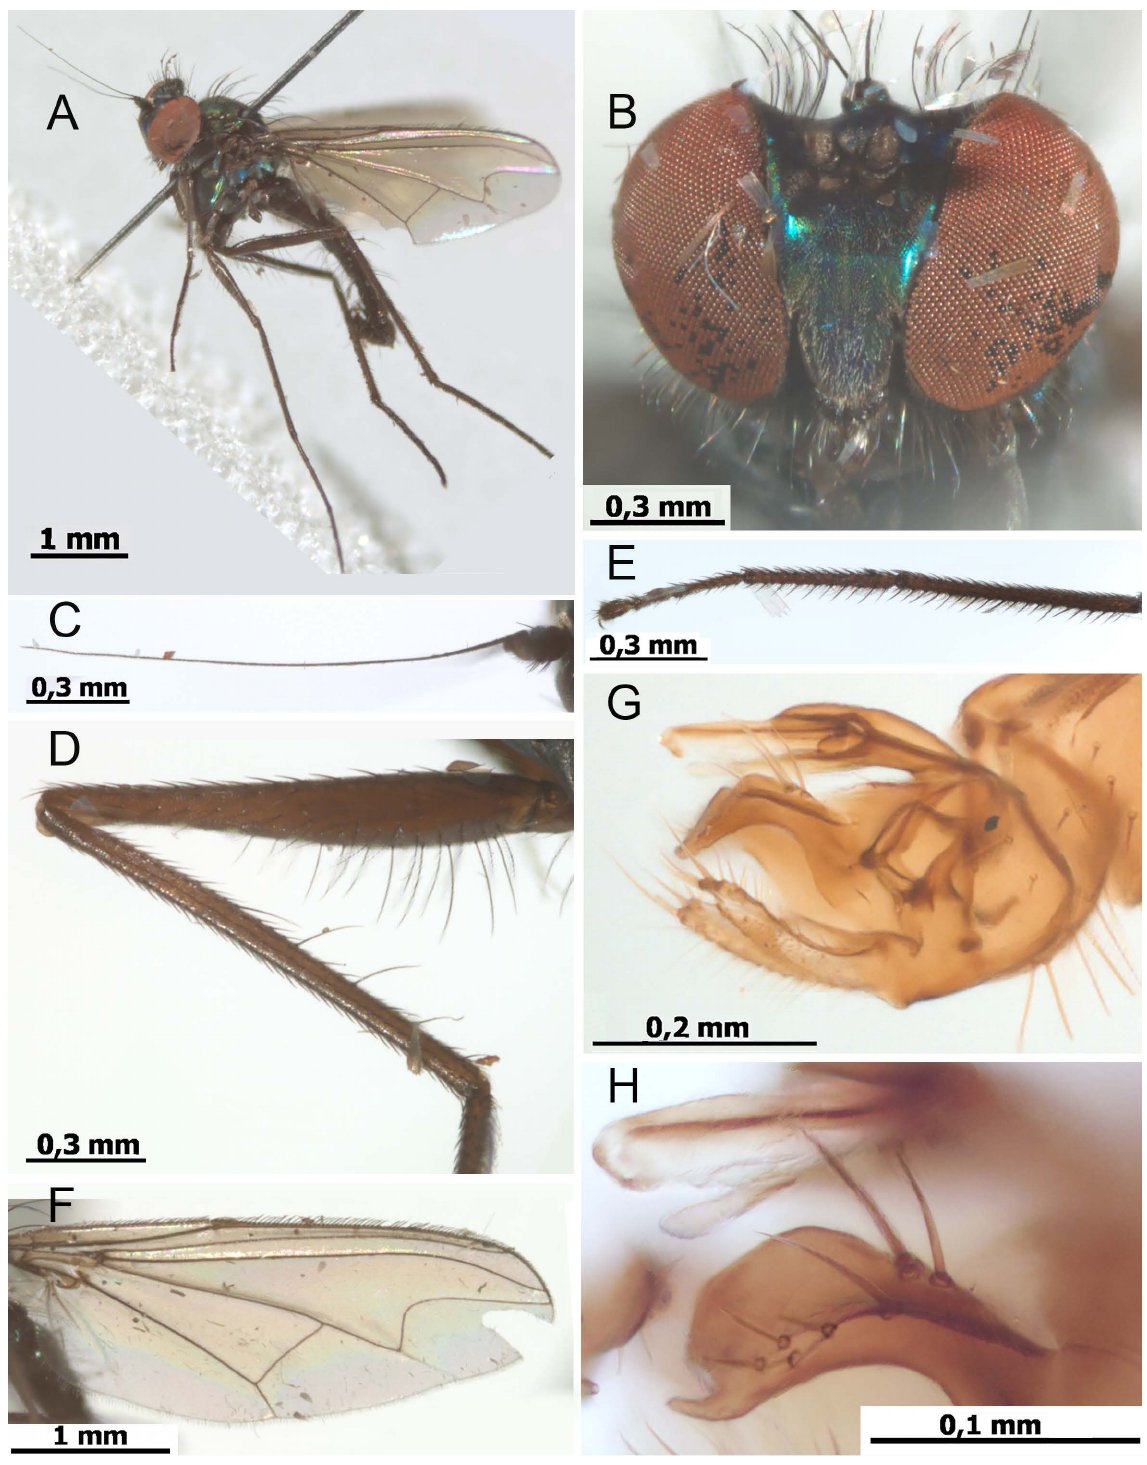
Fig. 1. Amblypsilopus ankarana sp. nov. Holotype, ♂ (AMGS). A . Habitus. B . Head. C . Antenna. D . Fore femur and tibia. E . Fore tarsus. F . Wing. G . Hypopygium, left lateral view, reflected light. H . Surstylus, ventrolateral view, transmitted